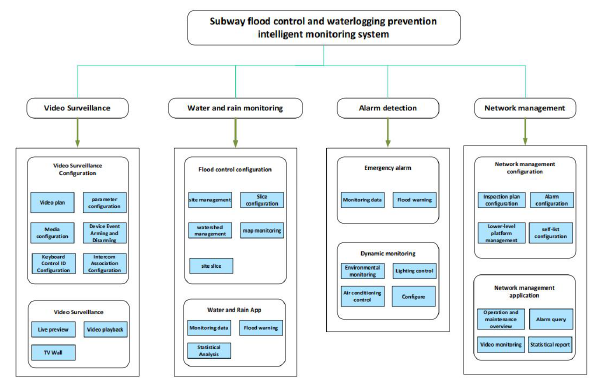
Figure 2 . System functional architecture diagram.